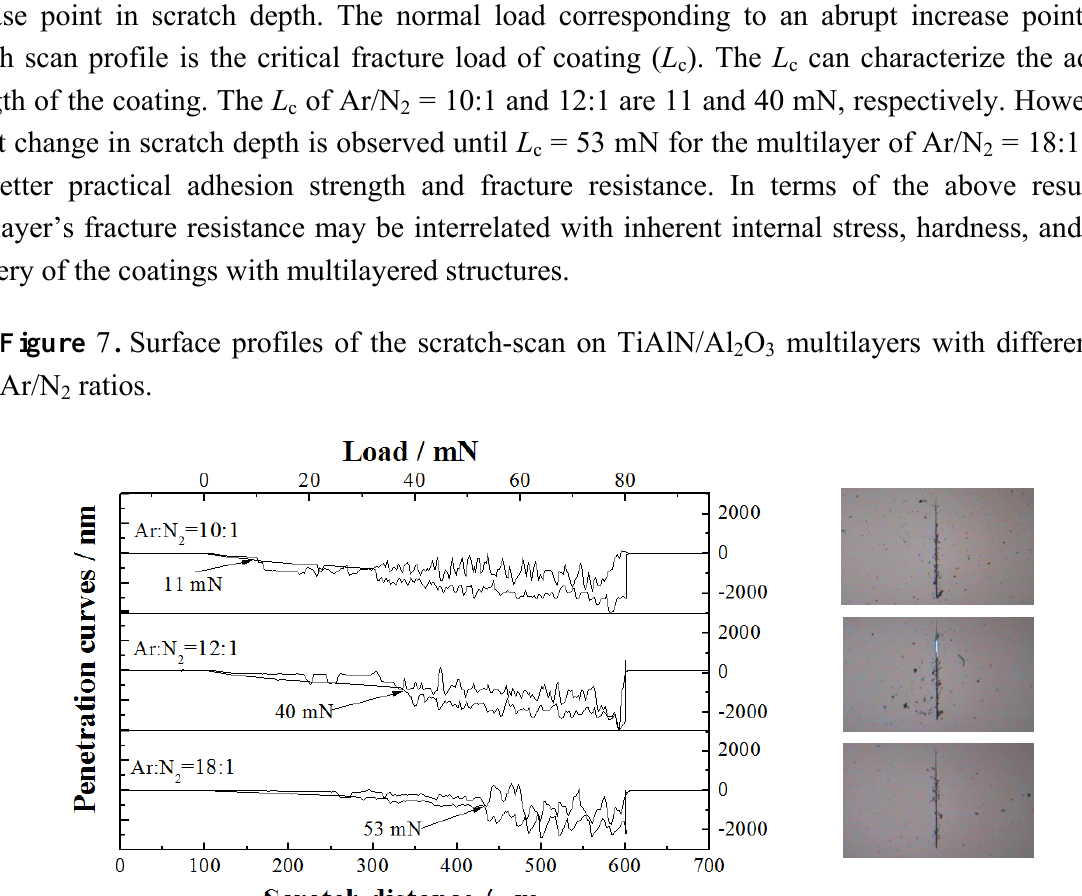
O multilayers with different 2 3